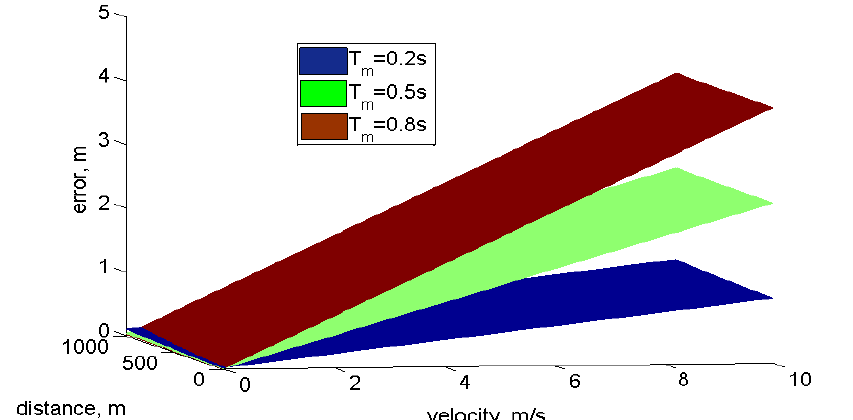
Figure 10. Distance calculus error as a function of prototype travel velocity with different measurement